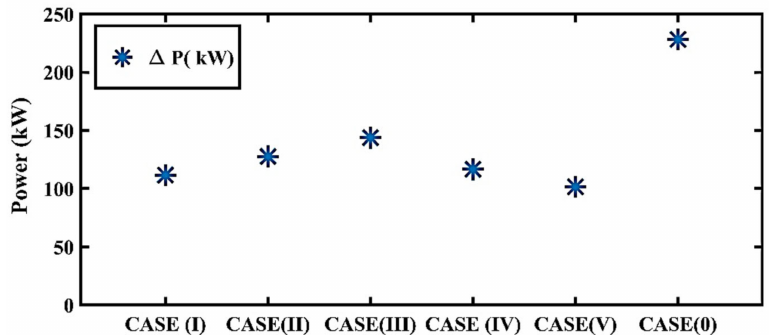
Figure 11. Grid power deviations (standard deviations) for different